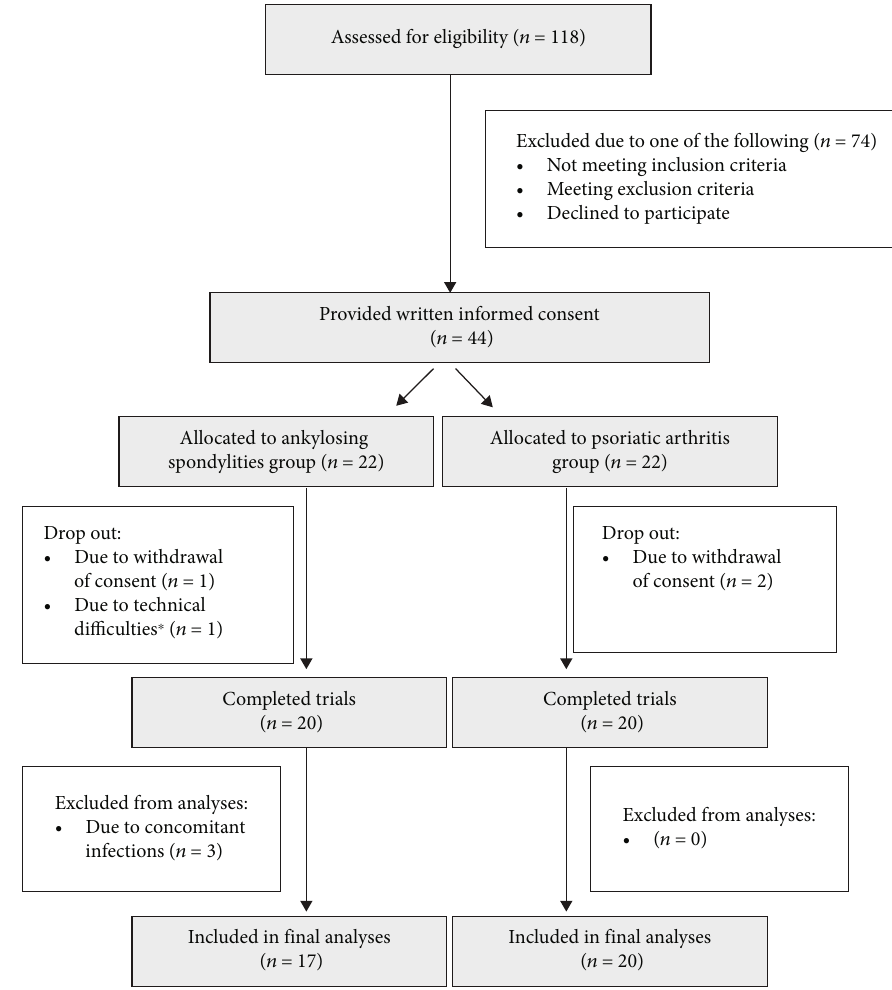
Figure 2: Flowchart illustrating screening process. ∗ Temporary failure in the ECG-recording